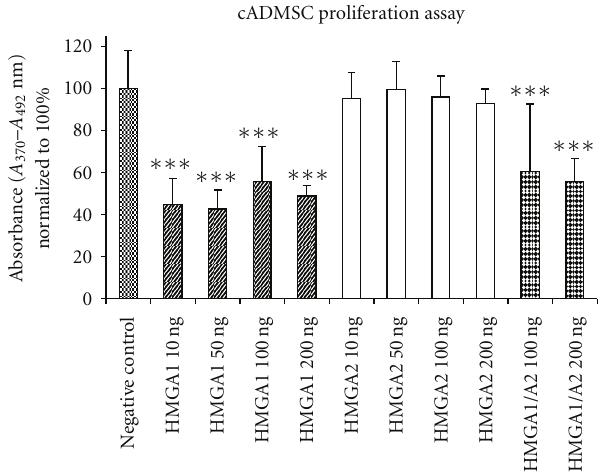
Figure 2: Proliferation test of cASCs stimulated with HMGA pro- teins. Absorbance values were normalized to 100% in the negative control condition, significance levels are given for comparisons versus negative control condition. HMGA1 at all used levels has significant suppressive e ff ects on cell proliferation ( P < 0 . 001). In contrast, cell proliferation in the HMGA2-treated groups resulted in no significant di ff erences in comparison to the control group at all chosen concentrations. The combined protein application of 100ng and 200ng/mL shows a significant suppressive e ff ect on cASCs proliferation ( P < 0 . 001). For statistical comparisons a one-way analysis of variance and a Tukey posttest was carried out (significance levels: ∗ P < 0 . 05; ∗∗ P < 0 . 01; ∗∗∗ P < 0 . 001).